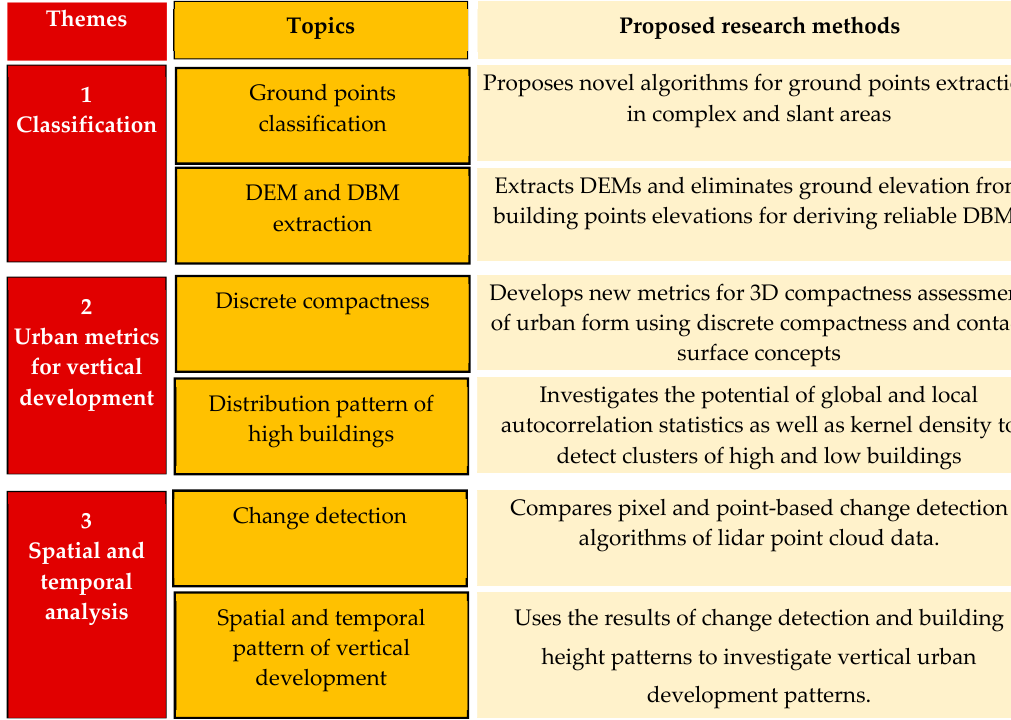
Figure 1. Three main themes including proposed topics and research methods in urban heights. DEM refers to digital elevation model. DBM refers to digital building model. See details of 3D compactness metrics.